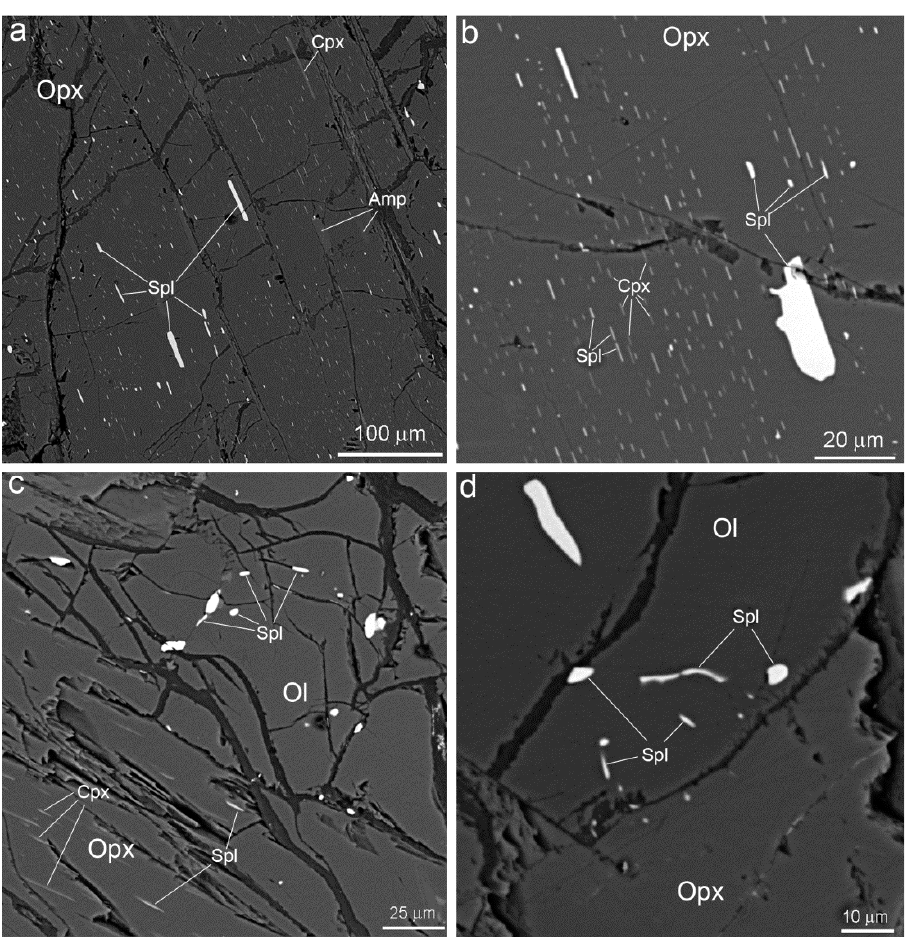
Figure 9. Cr-spinel tiny precipitates in olivine and enstatite grains: ( a )—Opx porphyroclast with numerous diopside, pargasite and spinel lamellae; ( b )—Detailed images of the grain: we can see growing holly-leaf Cr-spinel grain oriented parallel to lamellae; ( c )—Tiny spinel precipitates in olivine grain, as well as spinel and diopside lamellae in adjacent enstatite grain; ( d )—Tiny spinel precipitates in olivine grain close to boundary with enstatite grain, as well as larger spinel precipitates in olivine at a distance. All images—sample 820/300.